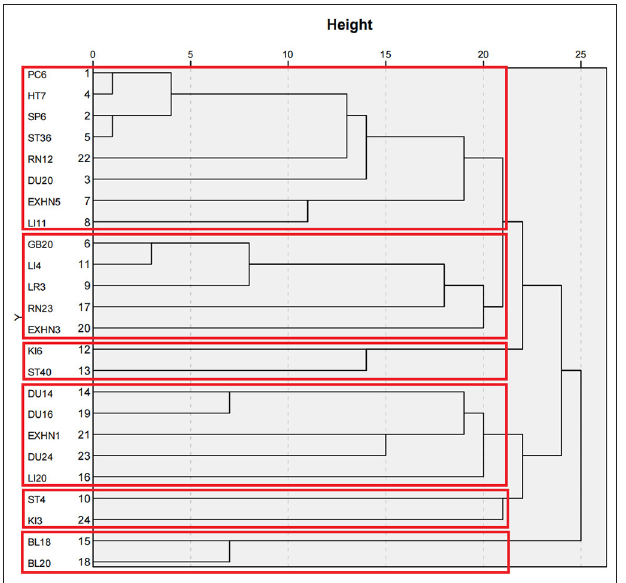
FIGURE 9 | Acupoints association network of acupuncture for TD treatment.